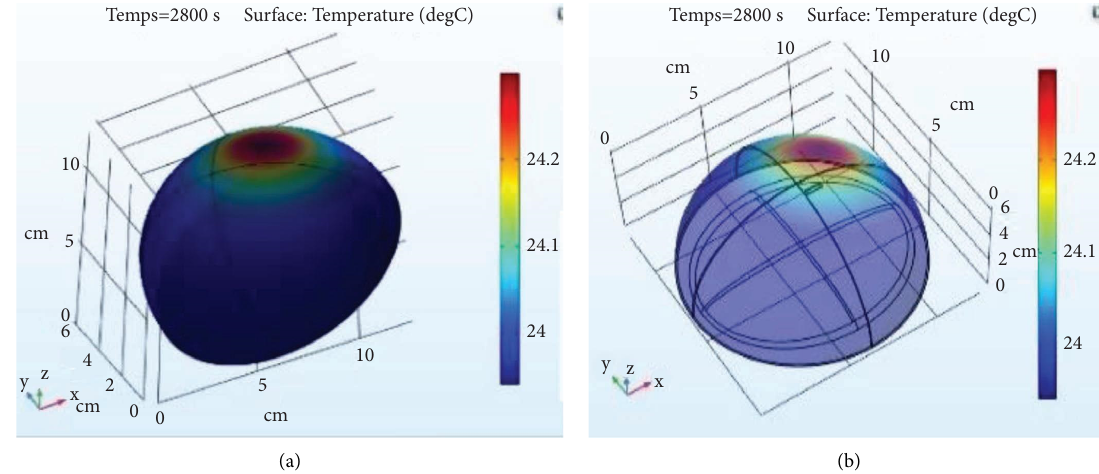
Figure 7: Image of breast phantom with UIQ tumor (a) Simplifed phantom model and (b) Approximated phantom